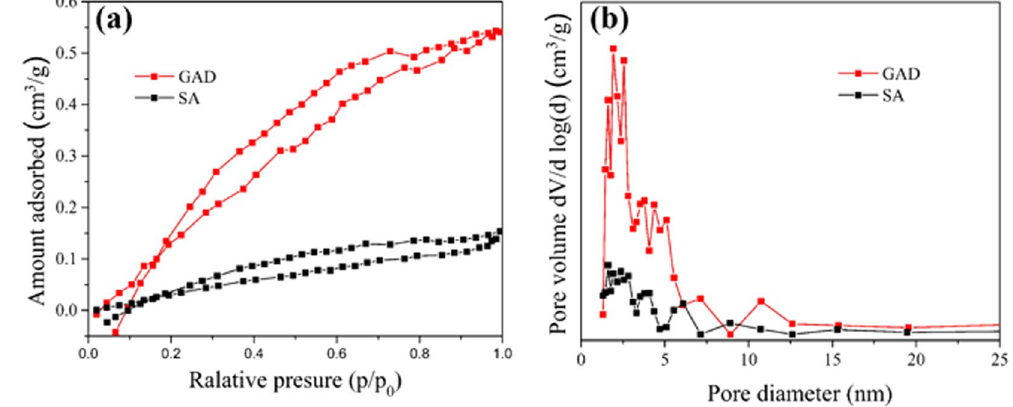
Figure 1. N 2 adsorption and desorption isotherms ( a ) and pore size distributions ( b ) of GAD and SA.